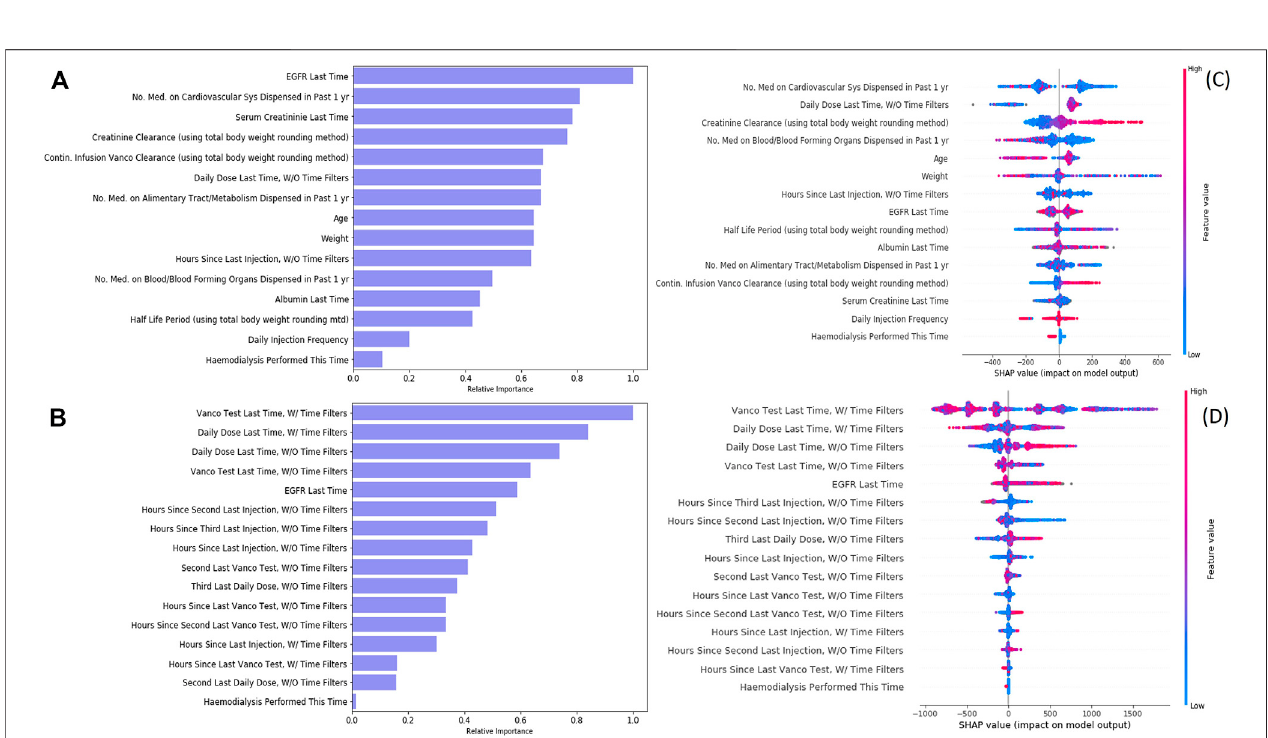
FIGURE4| Featureimportanceand featureimpact ofvancomycininjectionmodels. (A) Featureimportanceoftheinitialdosemodel. (B) Featureimportanceofthe subsequent dose model. (C) SHAP result of the initial dose model. (D) SHAP result of the subsequent dose model.